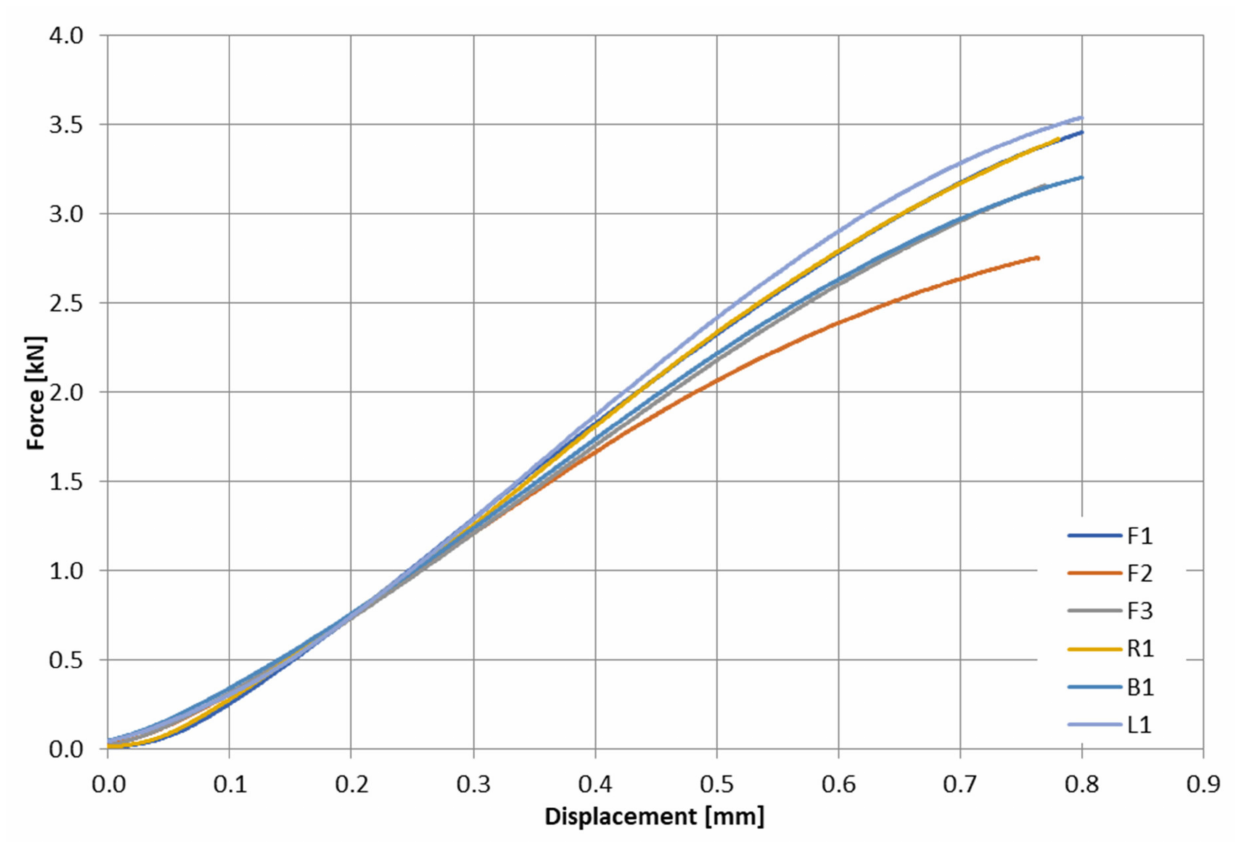
Figure 6. Results of three-point bending test.